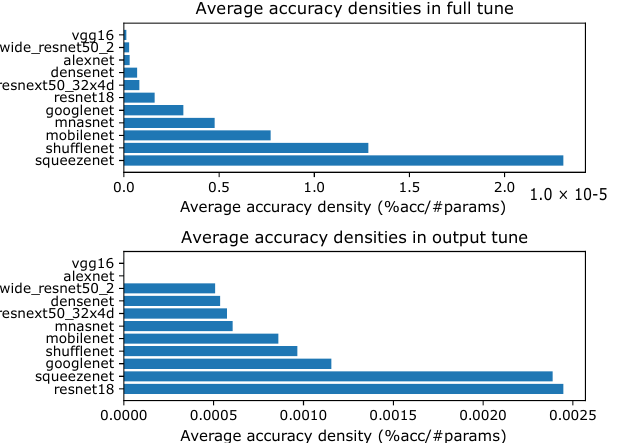
Figure 4. Average accuracy densities with full tuning and tuning the classifier layer only for ten